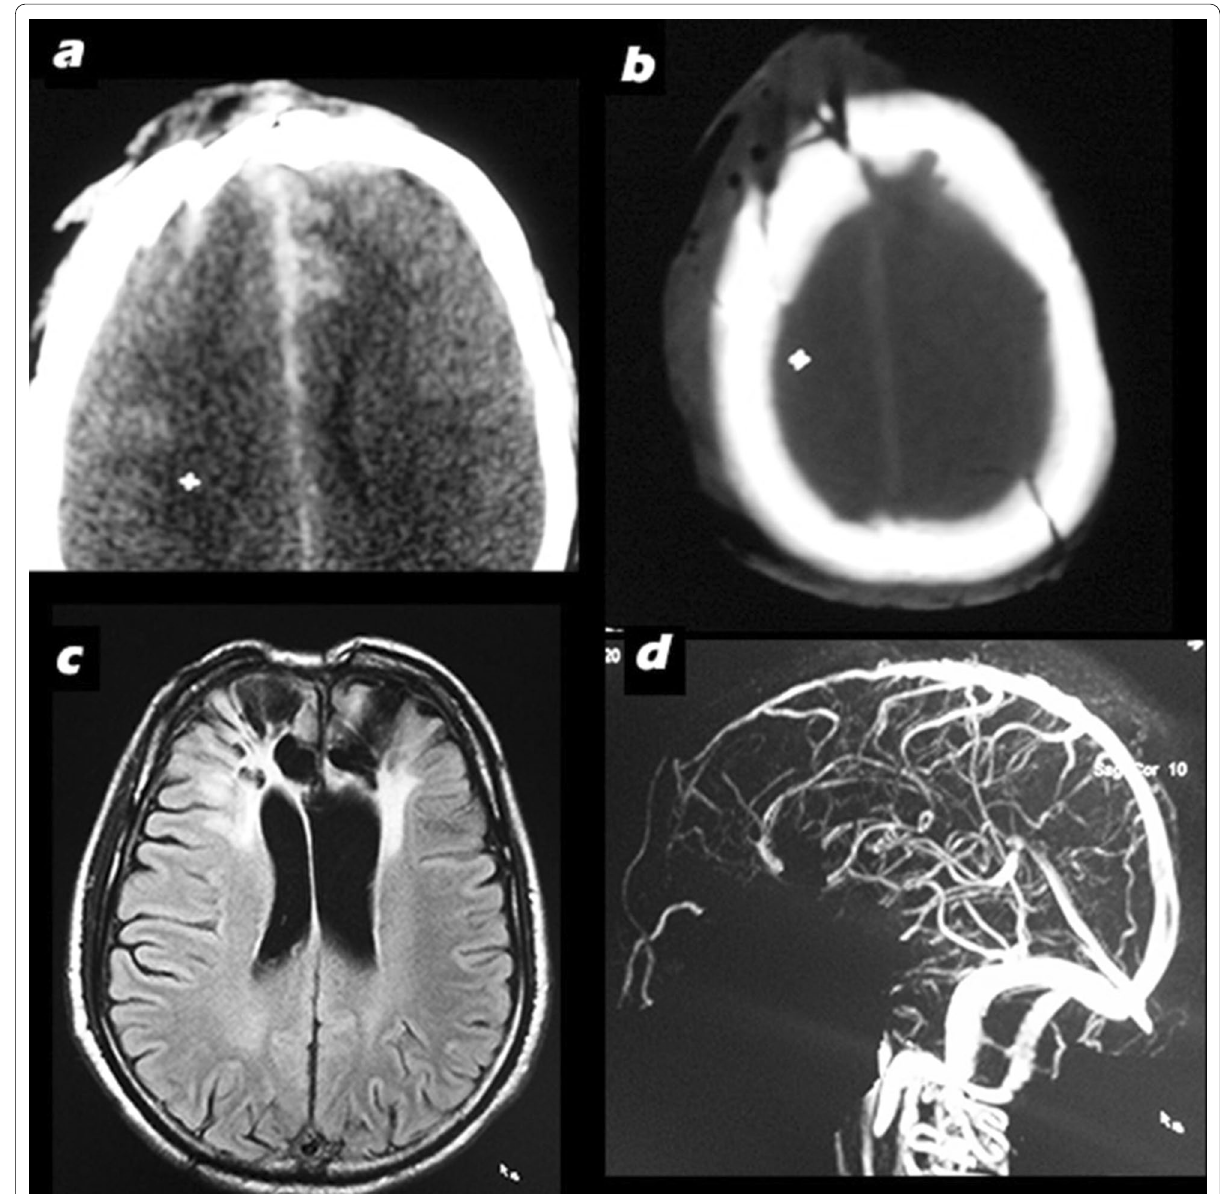
Fig. 2 a CT brain showing comminuted depressed fractures with interhemispheric bleed and subarachnoid hemorrhage; b CT bone window showing depressed bone fracture segment in midline; c MRI brain showing bifrontal gliosis; d MR venogram showing narrowing of anterior third of superior sagittal